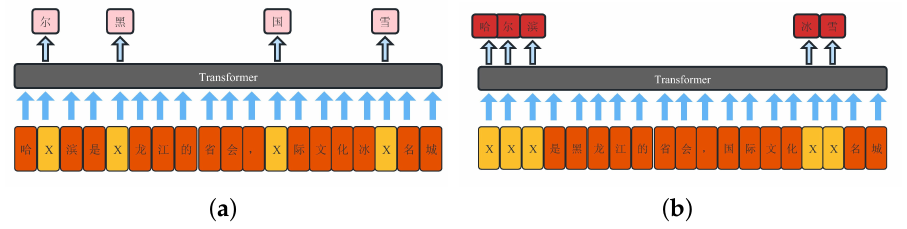
Figure 2. Comparison of Bert model masking method and ERNIE model masking method. ( a ) BERT model masking method; ( b ) ERNIE model masking